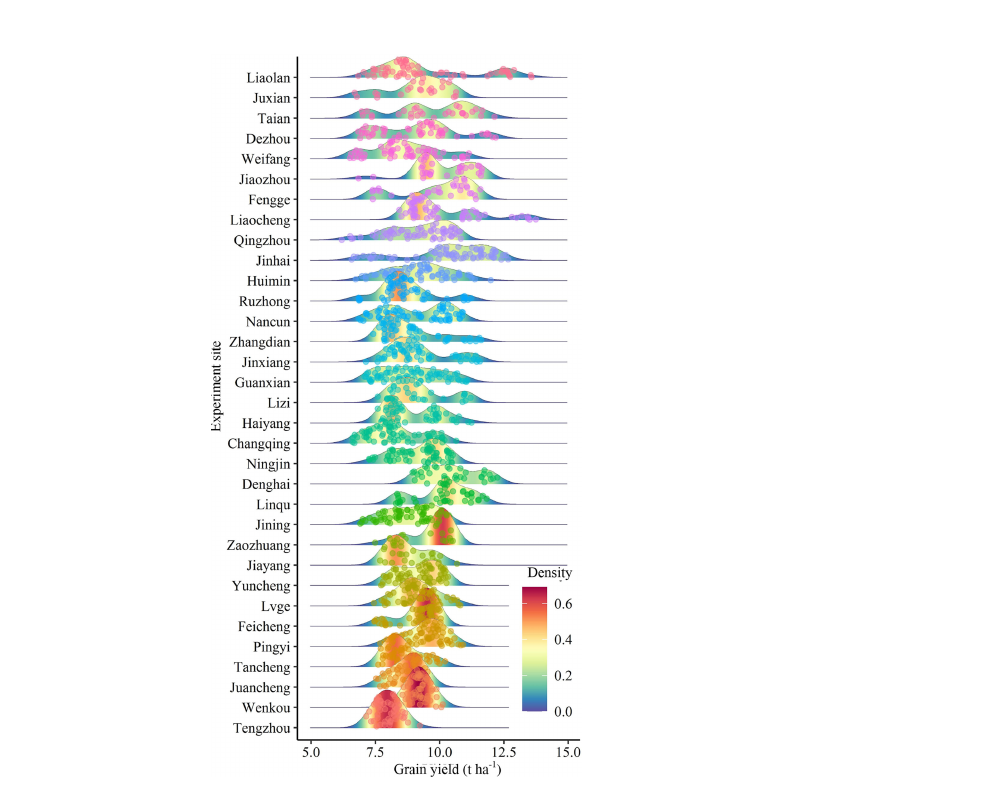
FIGURE 3 Analysis of yield distribution at different experiment sites. The redder the color and the higher the peak, the more points of distribution.